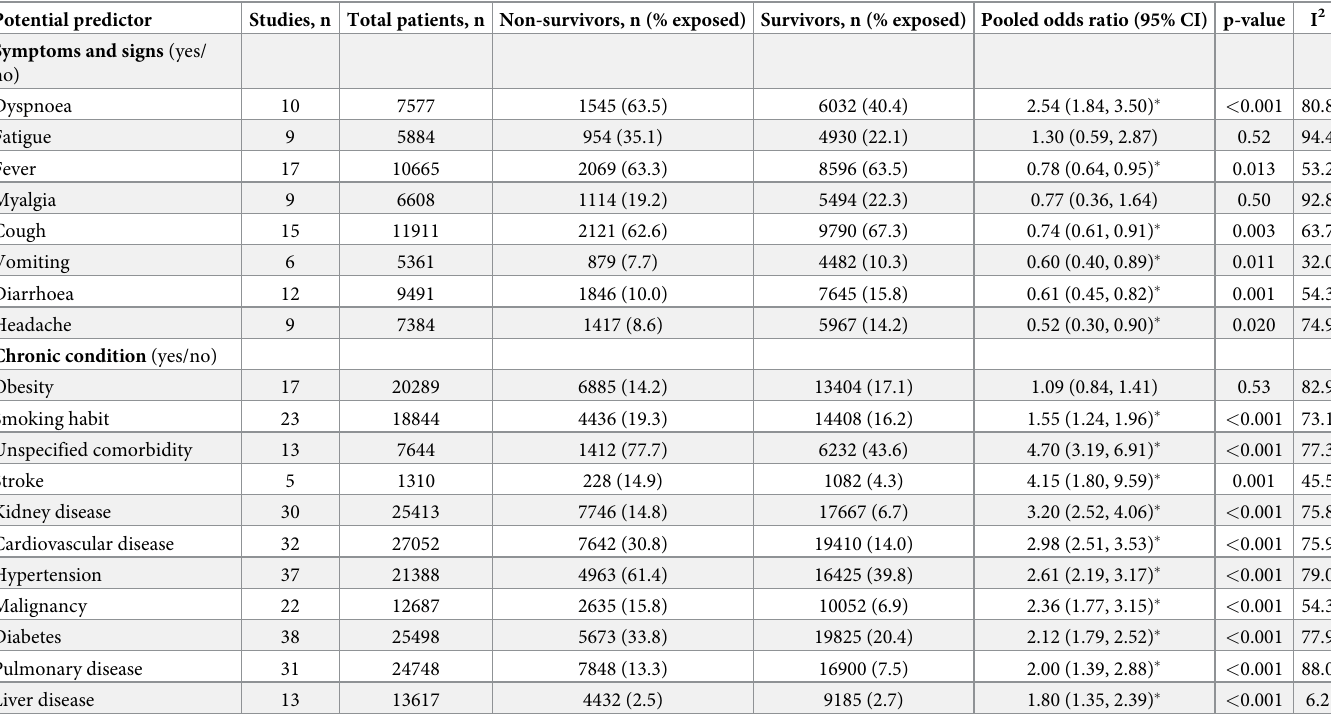
Table 2. Meta-analyses of sociodemographic and clinical potential predictors of in-hospital